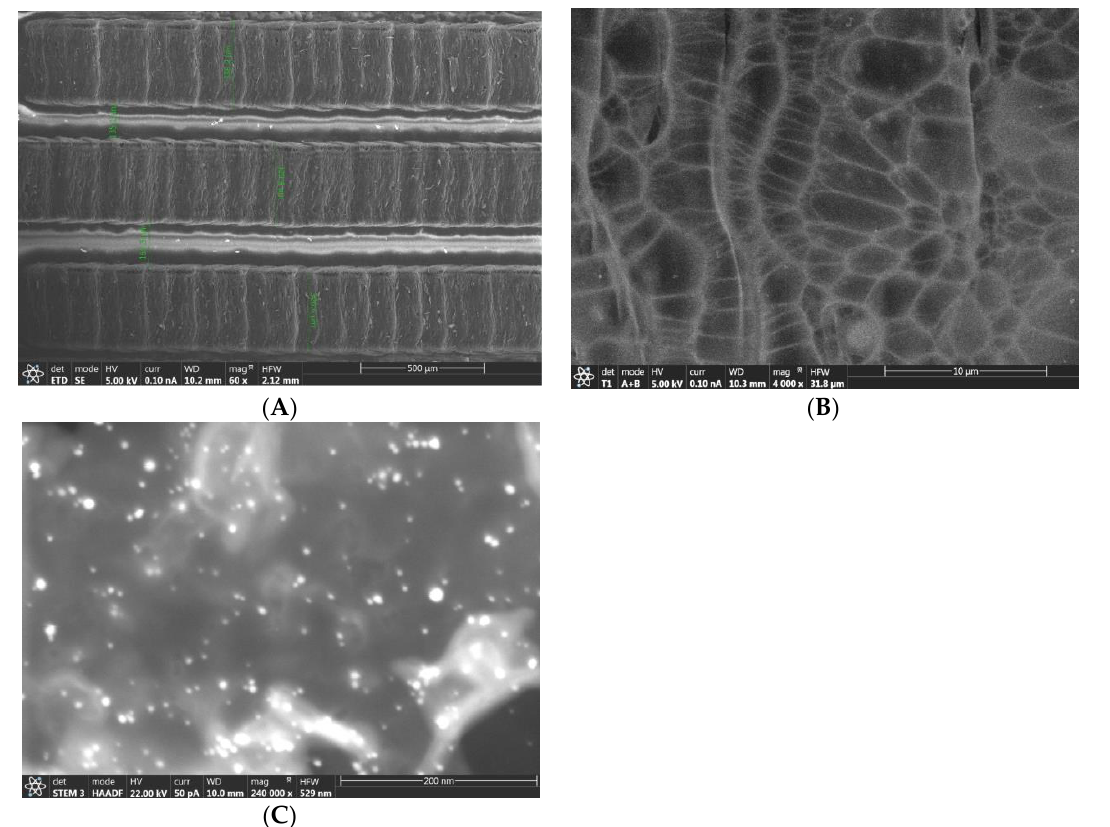
Figure 2. (A – C) SEM images of the IDGE/Au nano in different